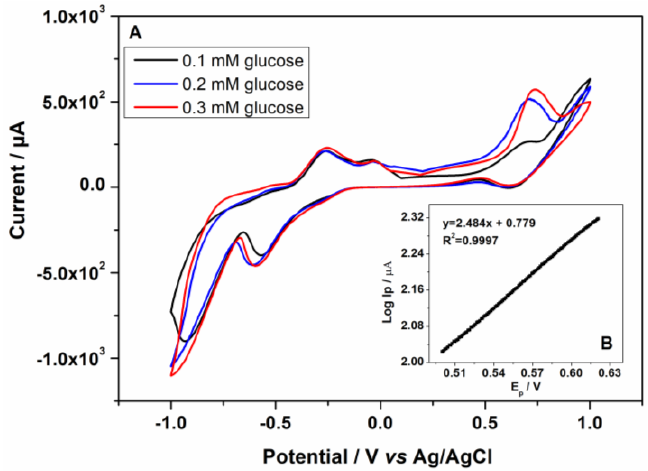
Figure 8. ( A ) Cyclic voltammograms of the Au-CuNC electrodes in the presence of 0.1, 0.2, and 0.3 mM glucose in 50 mM NaOH solution at 5 mV/s scan rate. ( B ) Tafel plot derived from the rinsing part of the CV obtained for glucose oxidation in 0.1 mM glucose in 50 mM NaOH solution at 5 mV/s.